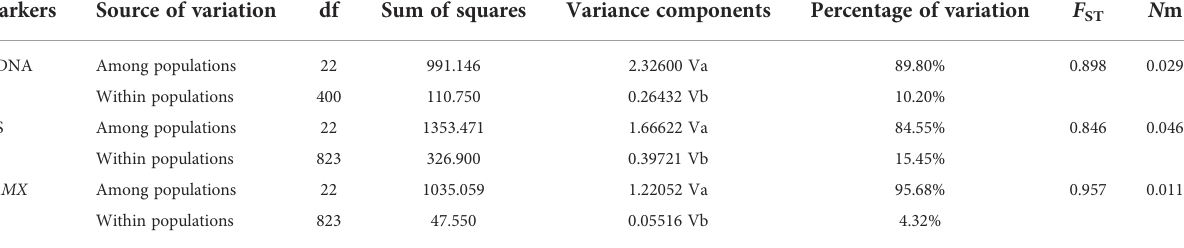
TABLE 2 Analysis of molecular variance (AMOVA) based on cpDNA and nDNA haplotype frequencies for populations.